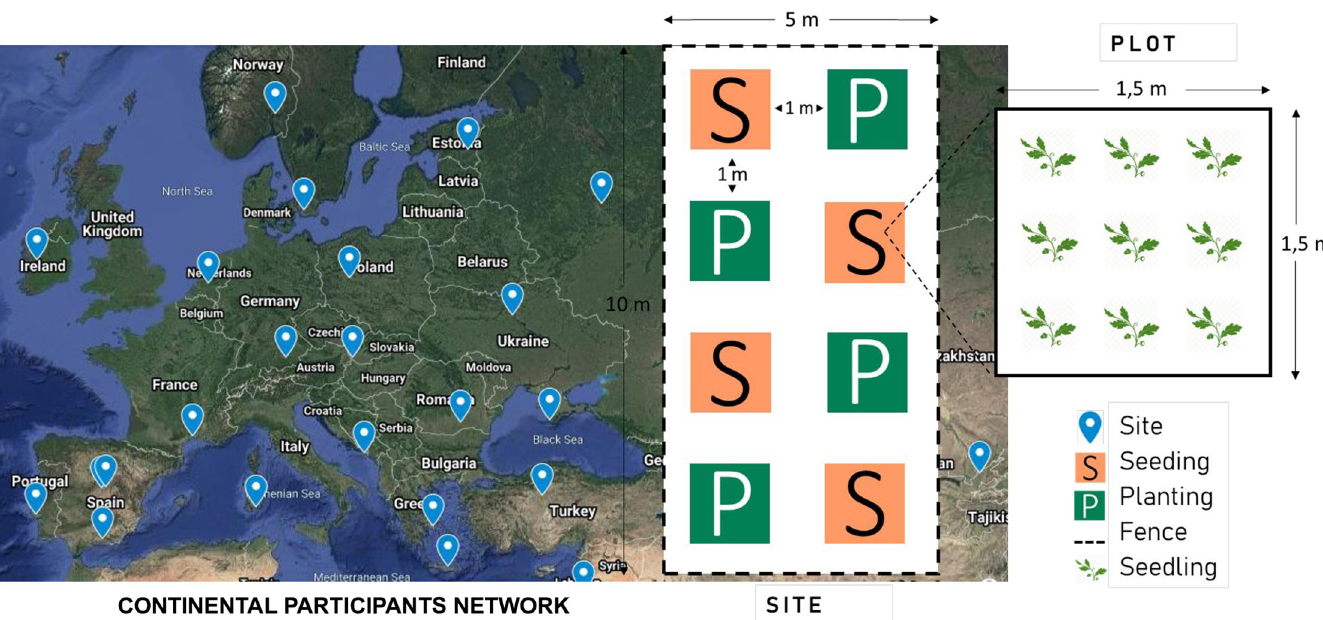
Fig 1. Study design. Across Eurasia, multiple sites will be established by voluntary participants (marks on the map). Each site will encompass at least eight plots, which constitute four replicates of two revegetation methods (S = seeding, P = planting). Each plot will contain nine plant-points with a target number of one sown or planted individual. A site may contain more species, in which case the number of plots would be 8 × the number of species. The map shows hypothetical locations; an updated map showing the location of sites can be found here.